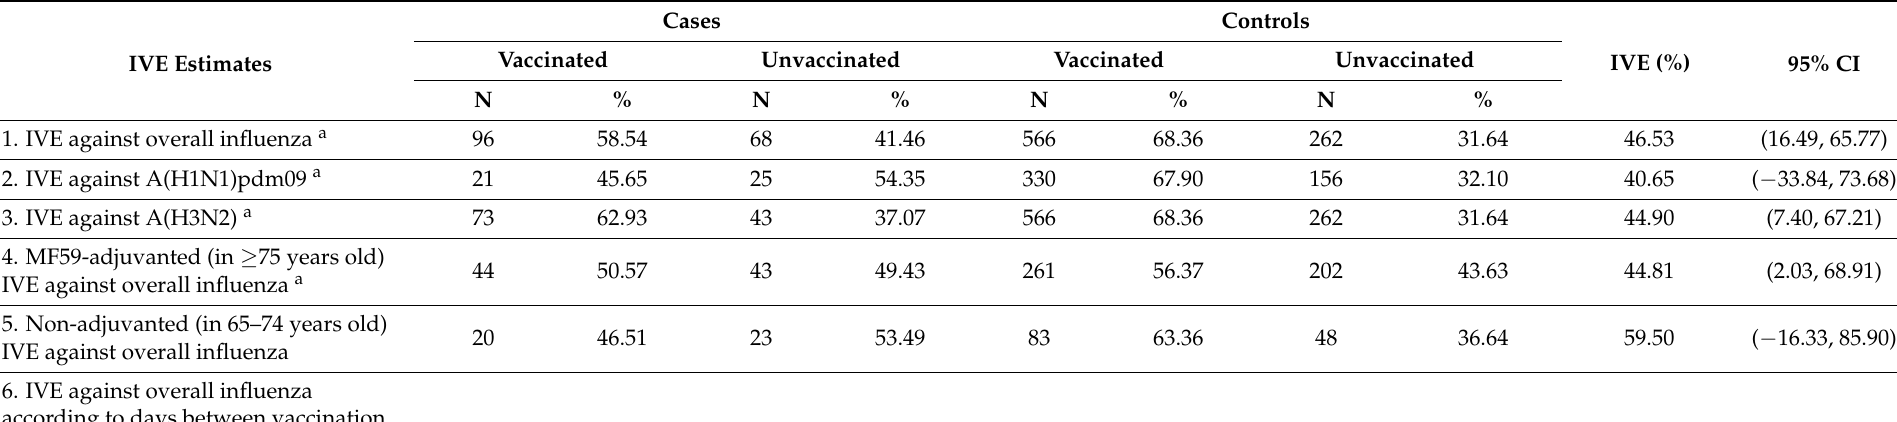
Table 2. Influenza vaccine effectiveness by strain, vaccine type and time since vaccination in hospital admissions (65 years old or over). Results from the Valencia Hospital Network for the Study of Influenza (VAHNSI) in the 2018/2019 influenza